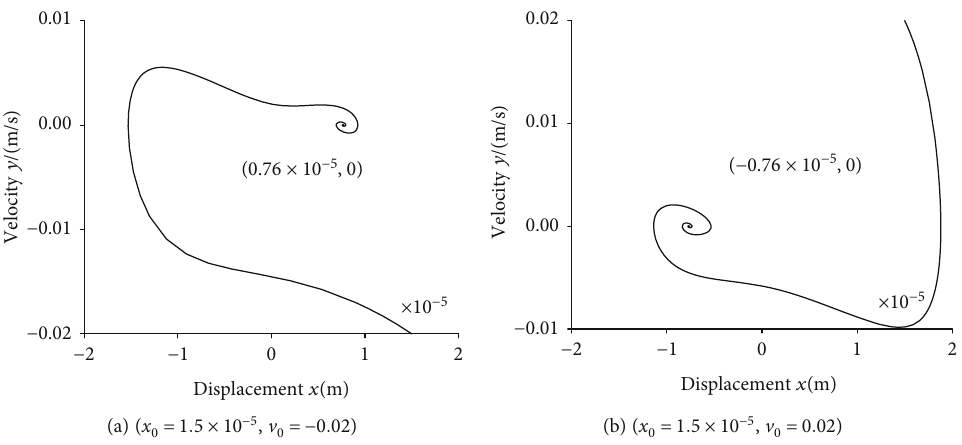
= 1 : 0A , q = 0 : 3 × 10 − 4 m 3 /s . 0 0